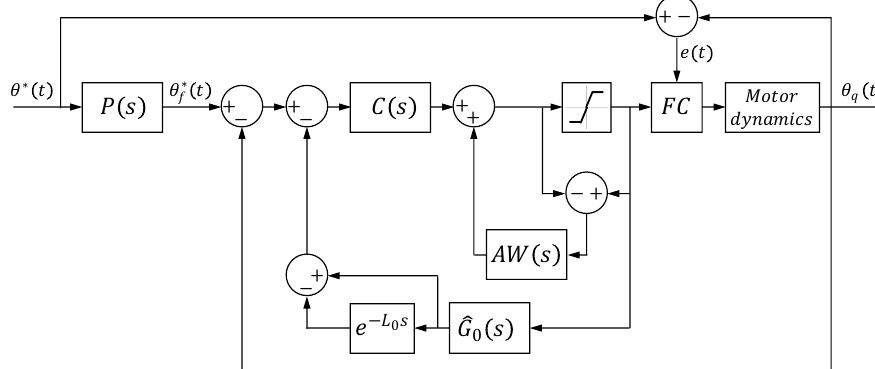
Figure 12. Full control